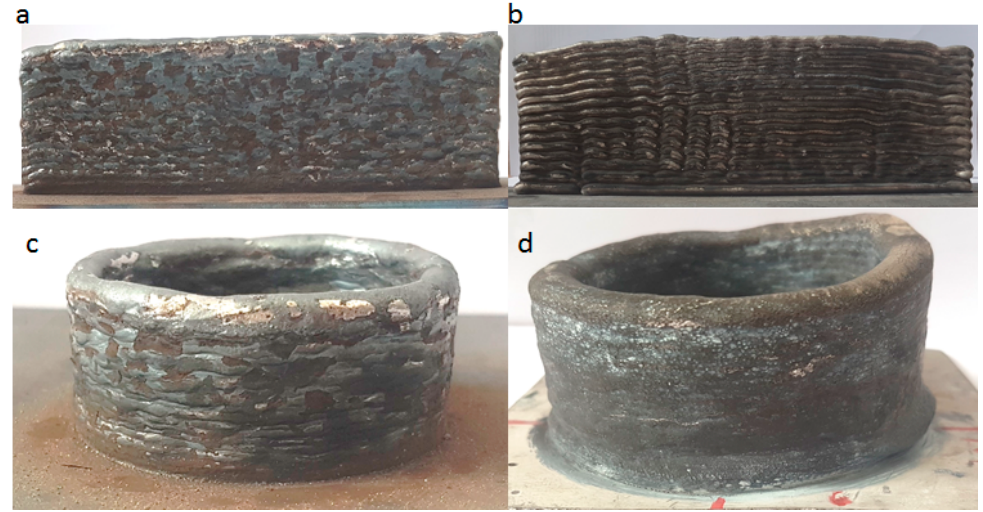
Figure 6. Semi-finished products, ( a , b ) wall and ( c , d ) pipe, made by WAAM with different materials, ( a , c ) G4Si1 and ( b , d ) AZ31.